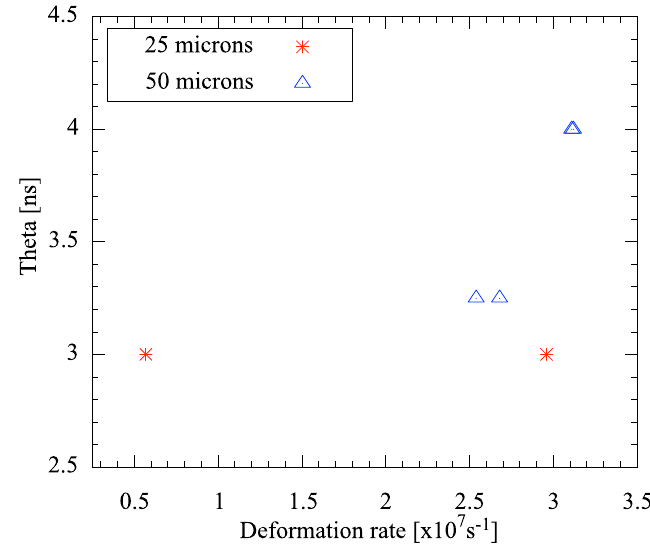
Figure 7. Variation of the completion time ( θ ) with the loading rate. For the 25 microns thick target, θ remains constant while for the 50 microns two distinct values of θ are